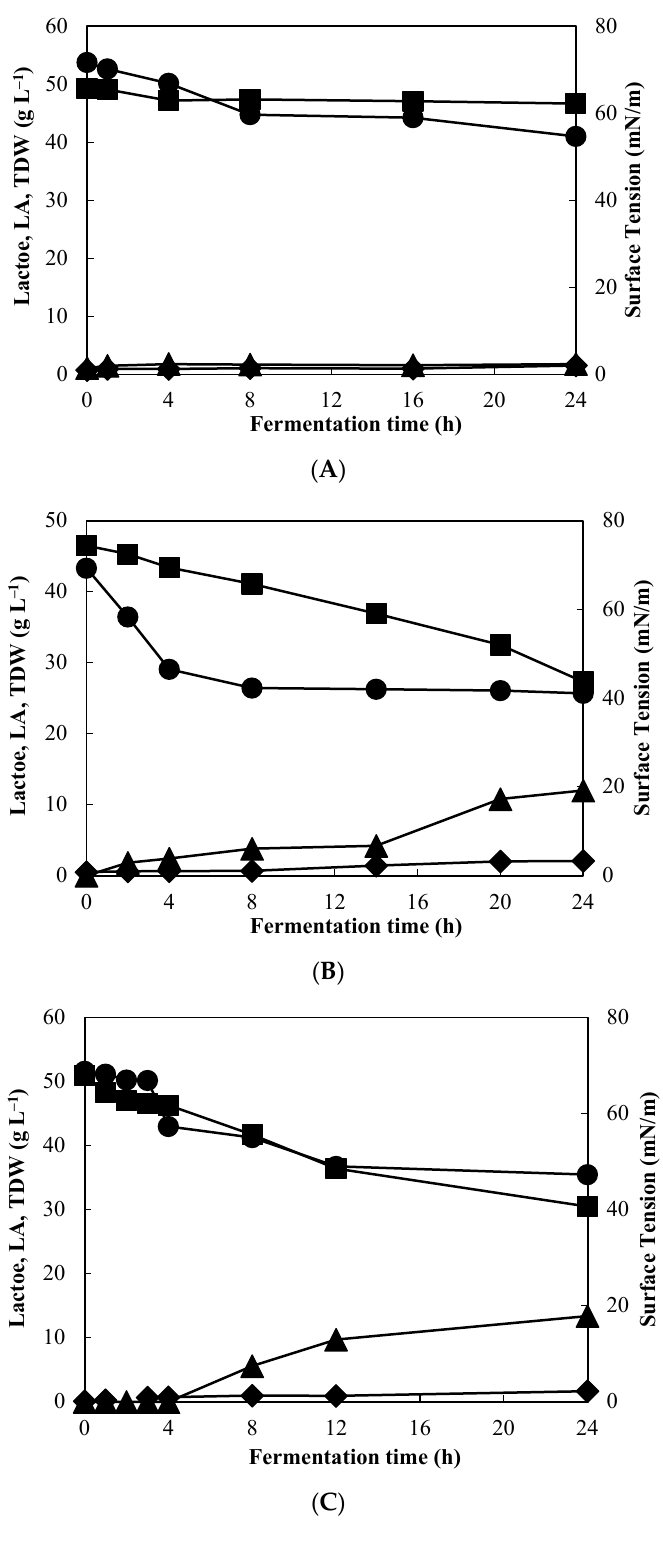
Figure 1. Profile change of (●) ST, ( ■ ) lactose, ( ▲ ) lactic acid (LA), and ( ◆ ) total dry weight (TDW) during fermentations using CWP with the strains L . plantarum E10 ( A ) and L. pentosus E108 ( B ) and L . fermentum ACA-DC 0182 ( C ).